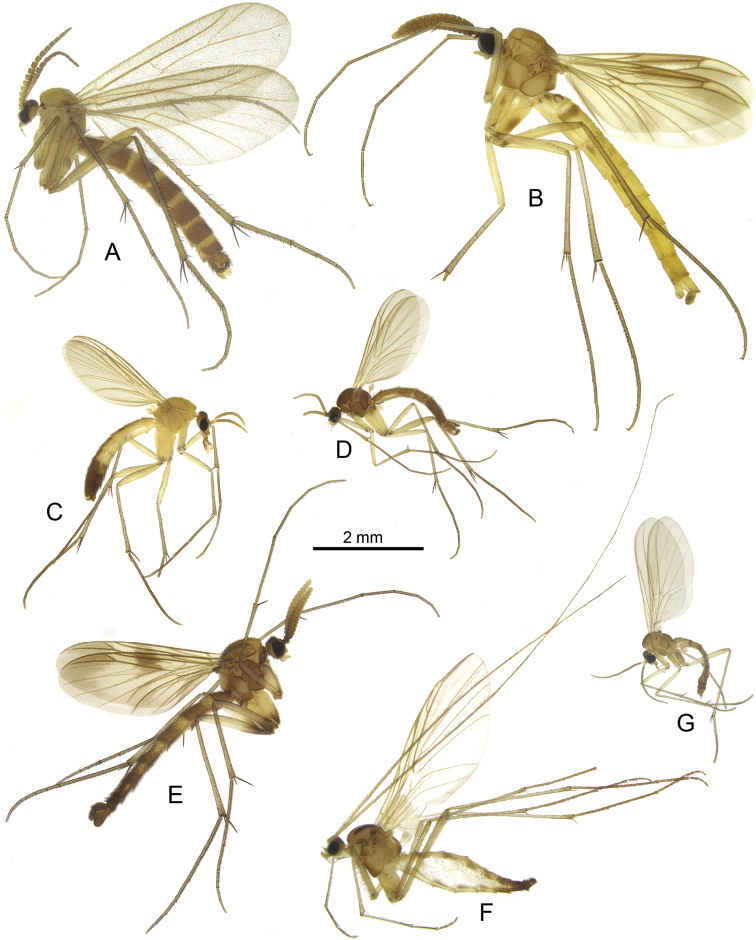
Habitus of Georgian fungus gnats of the families Ditomyiidae (A), Keroplatidae (B–F) and Diadocidiidae (G) ASymmerus
annulatus (Meigen, 1830) BKeroplatus
testaceus Dalman, 1818 CMacrorrhyncha
flava Winnertz, 1846 DPyratula
zonata (Zetterstedt, 1855) ECerotelion
racovitzai Matile & Burghele-Balacesco, 1969 FMacrocera
vittata Meigen, 1830 GDiadocidia (Diadocidia) spinosula Tollet, 1948.